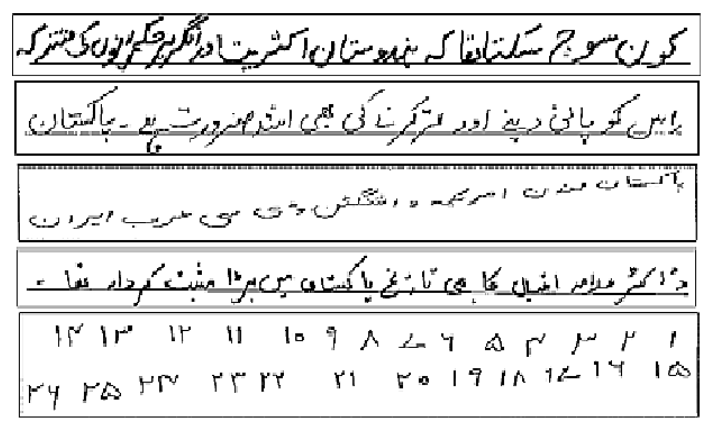
Figure 7. Different samples of input images with noise and without noise [47].